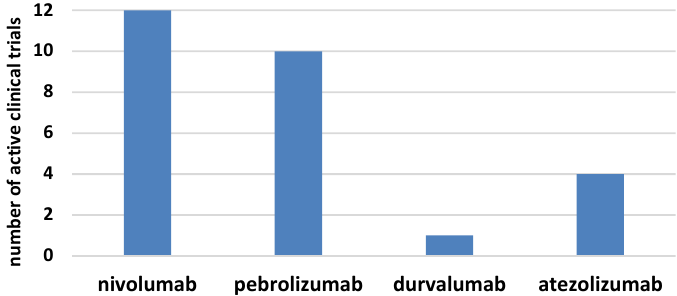
Figure 2. The numbers of active clinical trials for checkpoints inhibitors in acute myeloid leukemia.